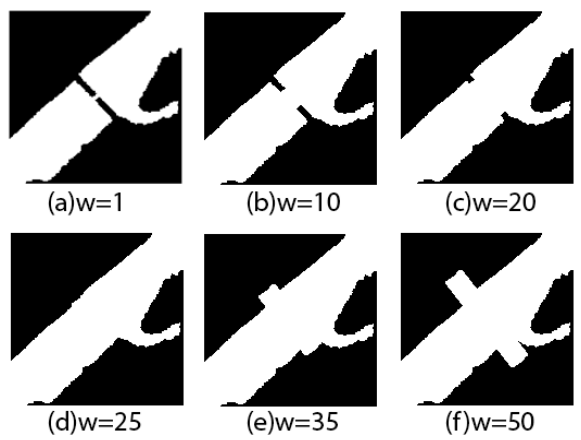
Figure 7. The growing centerline width to fill the gap between a river segment pair, with the centerline grows from width 1 (original mask), 10, 20, 25 (ideal width), 35, and 50 pixels in ( a )–( f ), respectively.